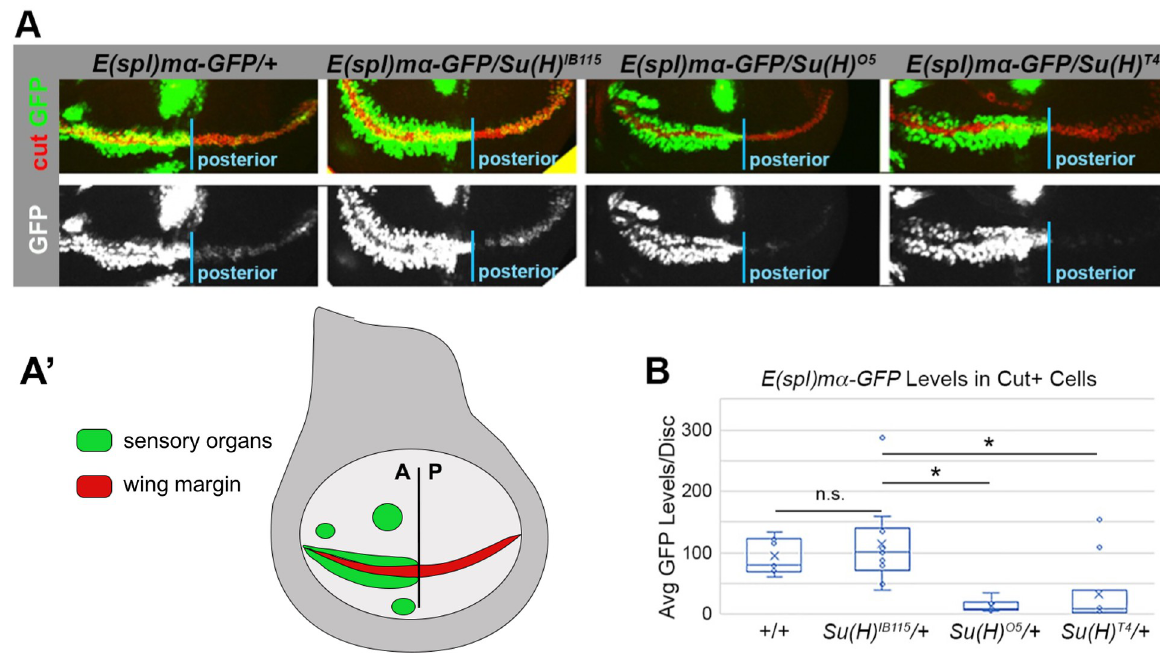
Fig 4. Flies with an AOS-like Su(H) allele have dramatically lower expression of a Notch reporter gene in wing margin cells. A-A’ . Representative expression of the E(spl)m α -GFP reporter in larval wing discs from WT flies (far left) or from flies heterozygous for either Su (H) IB115 , Su(H) O5 , or Su(H) T4 , as indicated at top. Note, the wing discs were immunostained for Cut (red) to mark the wing margin cells and only the posterior margin cells were quantified in B. We focused on the posterior margin cells to avoid the strong GFP staining in the neighboring sensory organ cells because the E(spl)m α -GFP reporter is strongly activated by proneural transcription factors in a Notch-independent manner within the sensory organs [25]. Bottom panel shows GFP expression in grayscale. A’. Schematic of the larval wing disc with the wing margin cells (red) and the sensory organs (green) highlighted. Note, the absence of macrochaetae cells in the posterior compartment. B . Quantification of GFP levels from wing discs of the indicated genotypes. Each dot represents the average posterior wing margin cell pixel intensity as measured from an individual imaginal disc. � denotes significance (p < 0.01) using a two-sided Student’s t-test.